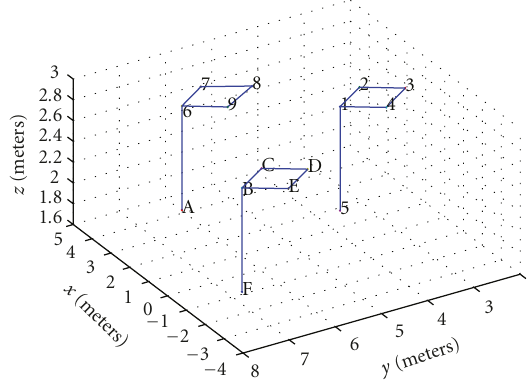
Figure 8: Microphones’